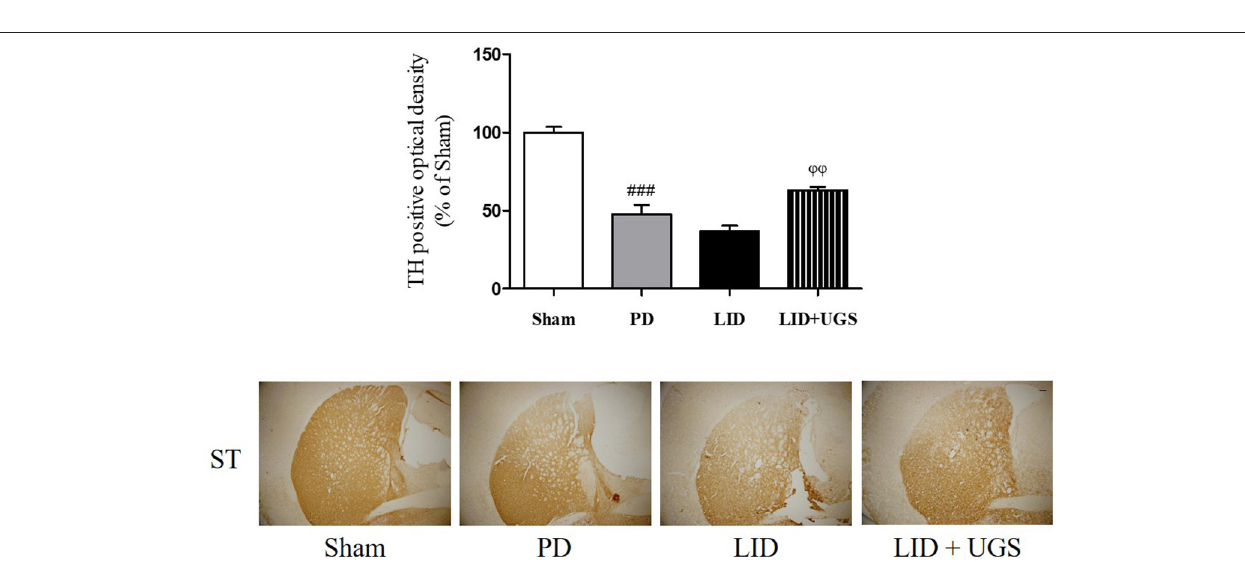
FIGURE 7 | UGS attenuated the dopaminergic neuronal loss in L-dopa chronically treated the mouse ST. The optical density of TH fibers in the ST was measured. Scale bar = 100 µ m. Values of quantification data were given as the mean ± S.E.M. ( N = 6). The significance of differences was analyzed by one-way ANOVA followed by Bonferroni’s Multiple Comparison Test: ### p < 0.001; mean values were significantly different from the sham group. φφ p < 0.01; mean values were significantly different from the LID group.